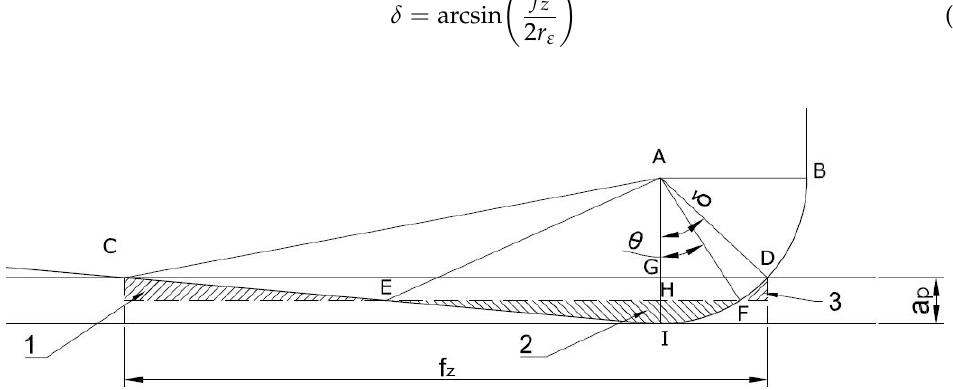
Figure 5. Sketch of one machine mark produced by a small feed per tooth. The dashed line was defined as the mean line, which made area 1 plus area 3 equal to area 2. Where: a p —depth of cut (mm), f z —feed per tooth (mm), δ and θ —are the angles (°).